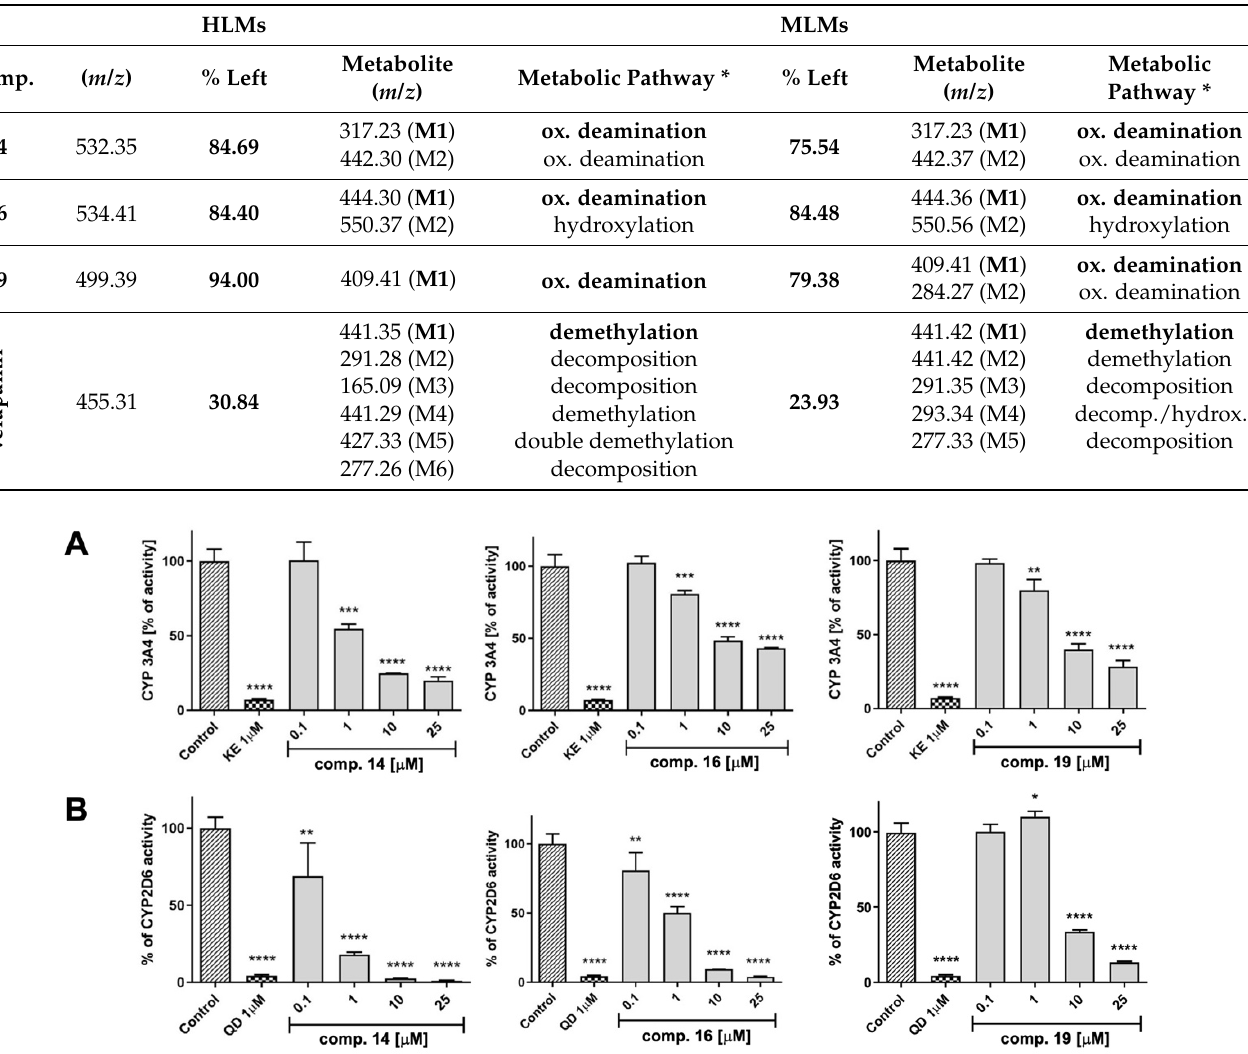
Table 2. The results of metabolic stability evaluation on human liver microsomes (HLMs) and mouse liver microsomes (MLMs) for compounds 14 , 16 , 19 and verapamil (control). * most probable metabolic pathways were estimated by MS analyses supported by in silico prediction using MetaSite 8.0.1; main metabolic pathways are bolded.